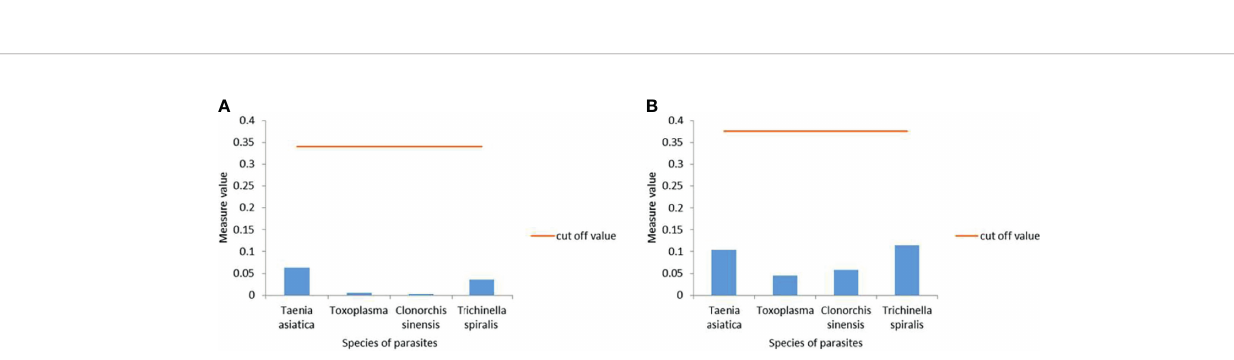
FIGURE 3 | (A) TSOL18 and (B) GP50, the up-converting phosphor technology-based lateral fl ow (UPT-LF) assay for detection of T. asiatica , T. gondii , C . sinensis , and T. spiralis , showed excellent speci fi city.